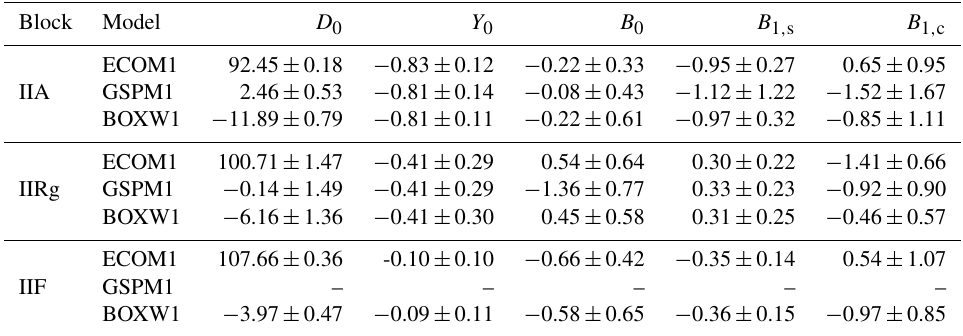
Table 3. The mean and standard deviations of estimated parameters based on ECOM1 parameterization (unit: nms − 2 ).